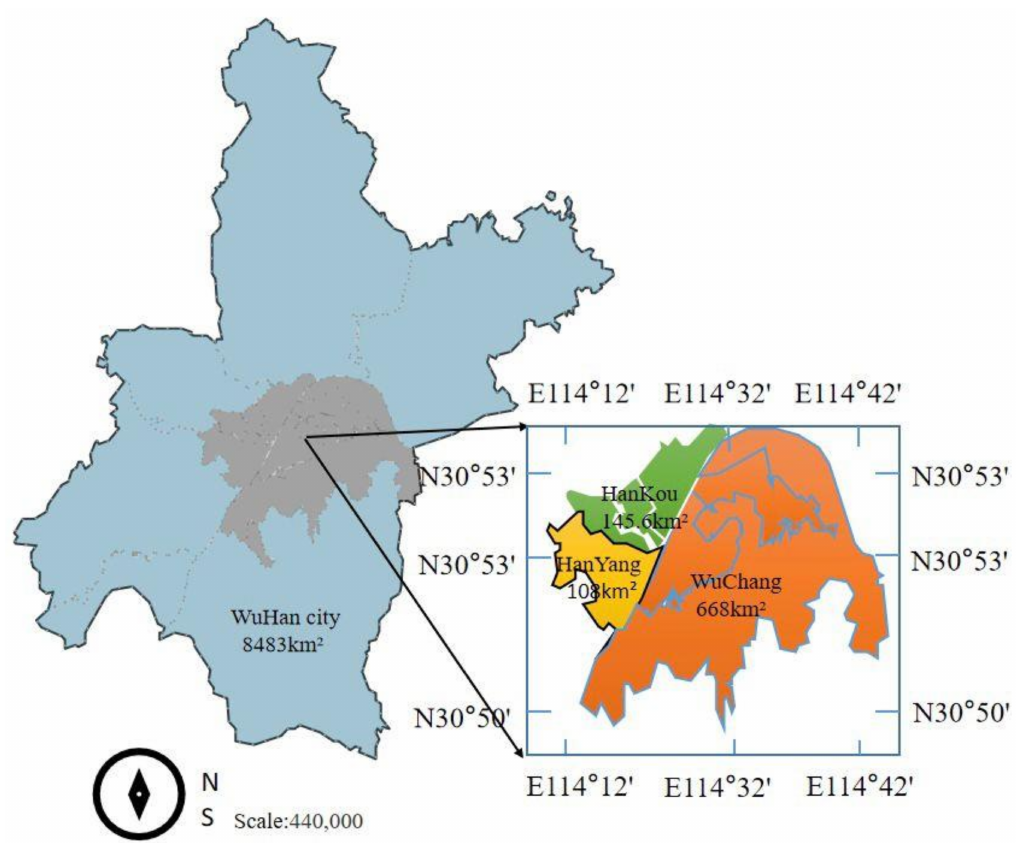
Figure 2. Map of the study